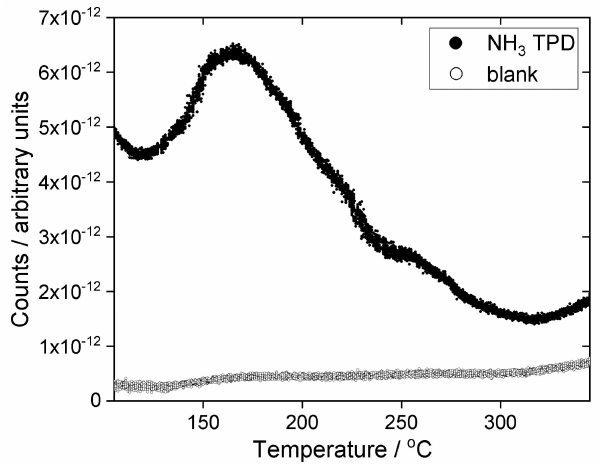
Figure 10. Temperature-programmed desorption of ammonia from MIL-88B(Fe,Sc), with data from a fresh sample of the material (without ammonia adsorbed) heated under the same conditions as a